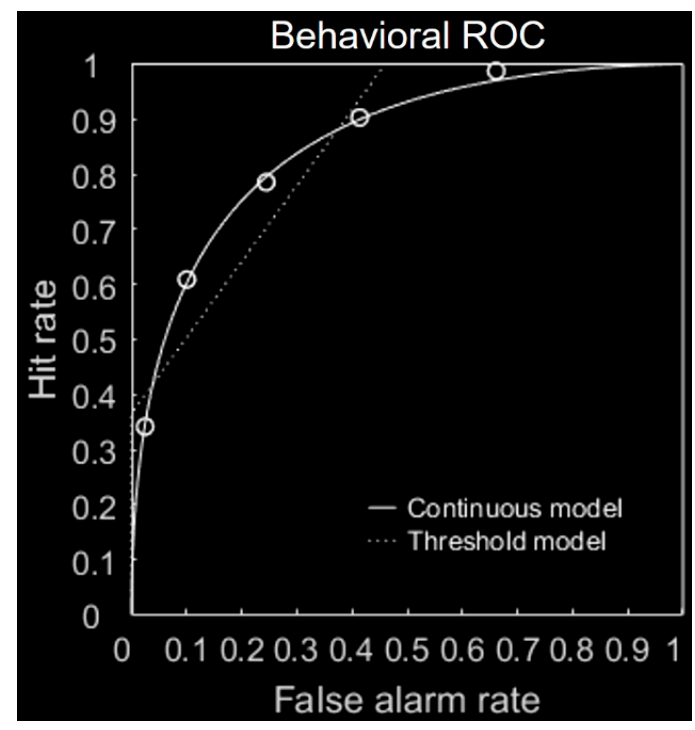
Figure A1. Behavioral ROC (circles) with the best-fit continuous unequal variance model and two-high threshold model ROCs (key at the bottom right).